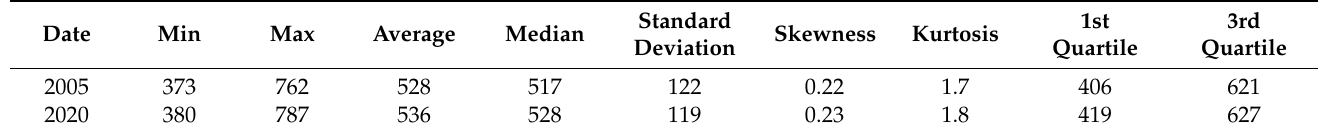
Table 1. Summary statistics of measurements of the groundwater level of the Saïss aquifer for 2005